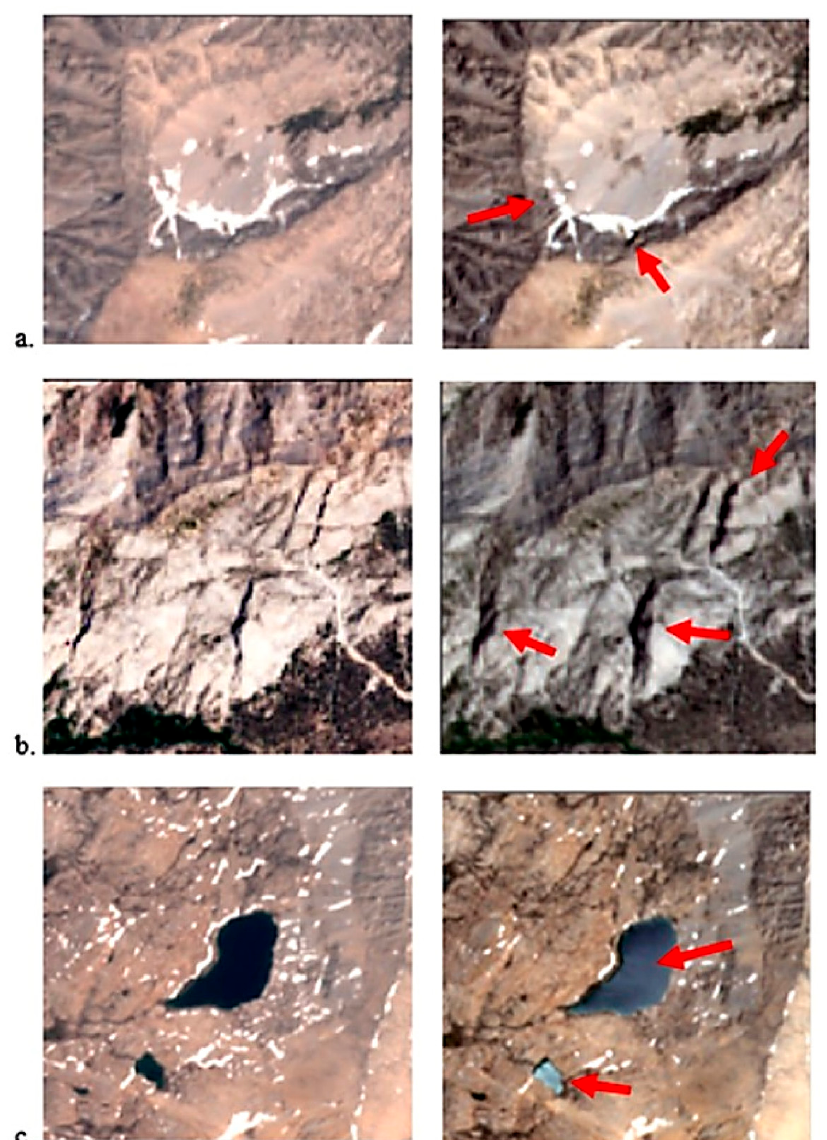
Figure 7. Brightness change rejection examples from the Mount Whitney region. Left and right image pairs are pre- and post-earthquake, respectively. ( a ) Snowfield change, ( b ) shadowing change, ( c ) lake/water body reflection. Red arrows in right hand images illustrate examples of areas with brightness changes that were eliminated.